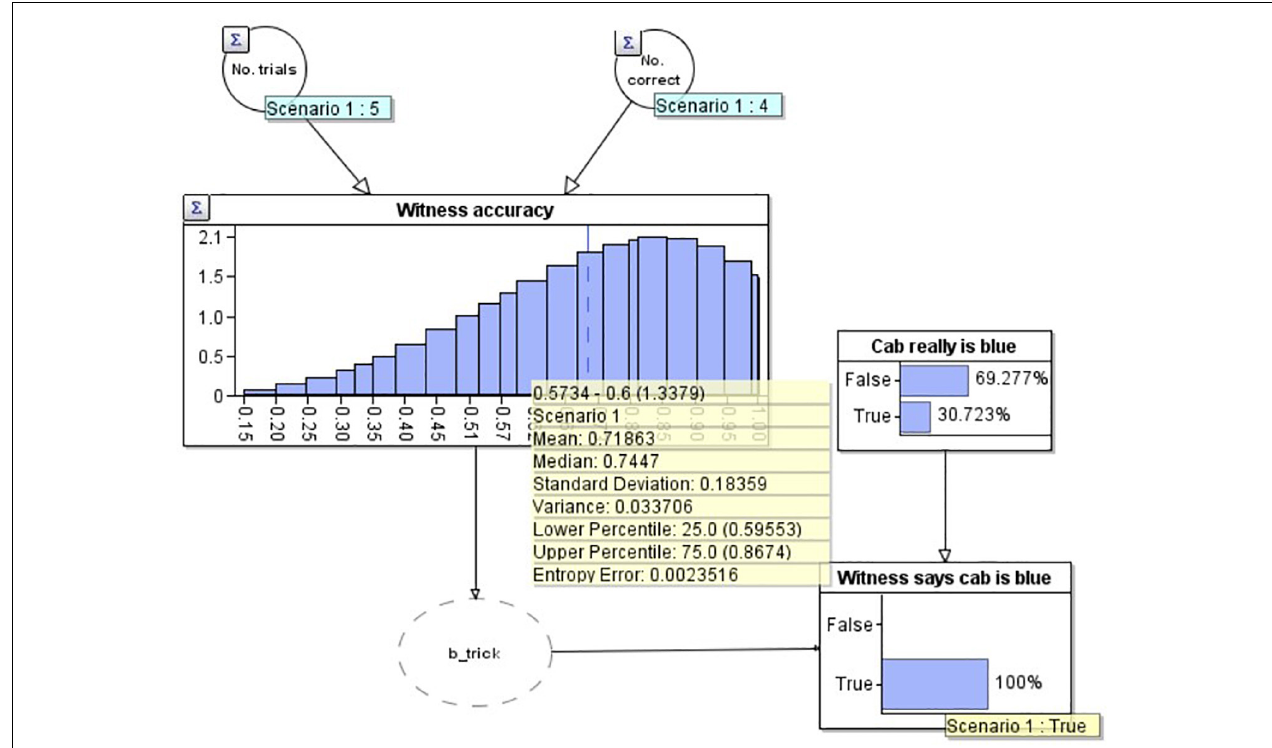
FIGURE 4 | A Bayesian network model depicting the situation where the witness has reported the cab is blue but we are uncertain if they are correct or incorrect.